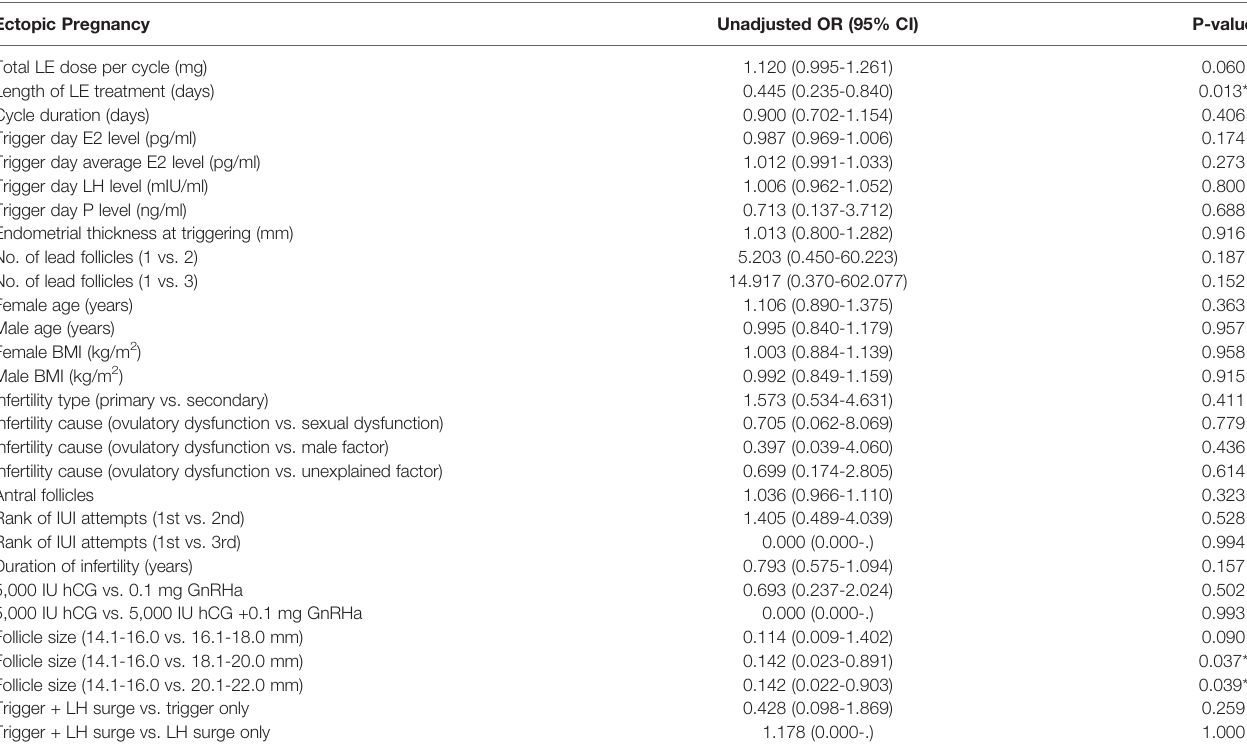
TABLE 5 | Binary logistic regression to account for variables associated with ectopic pregnancies after undergoing LE ovulation induction with IUI (n =6,285). Ectopic